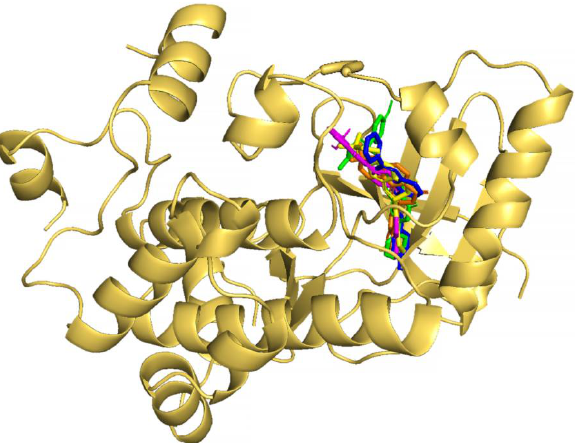
Figure 3. Molecular docking of top 5 selected flavonoids to MEK1. The protein is shown in cartoon representation colored yellow-orange, while compounds are shown in stick representations in various colors: binding of flavonoids ‘129696793’ (blue), ‘10813589’ (green), ‘10991656’ (orange), ‘10524567’ (yellow), and ‘10575055’ (magenta). Table 3. The MEK1 residues interacting with selected flavonoid (CID: 10813589) are listed with the number of non-bonding interactions and ΔASA.